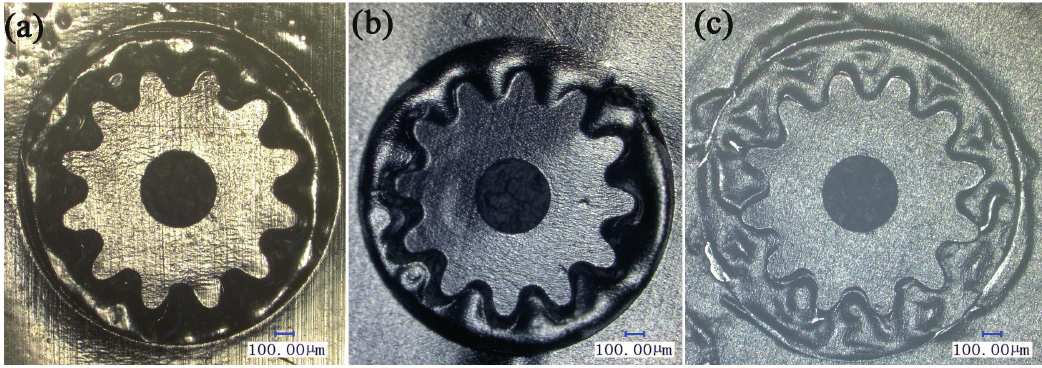
Figure 7. Top view of micro-gears punched by different thickness of polyurethane films: